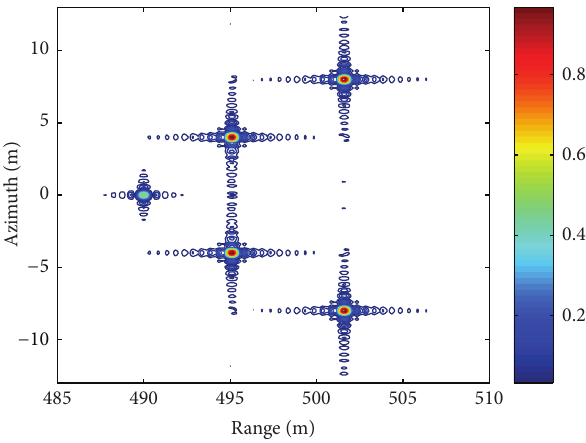
Figure 5: Azimuth and range 2D imaging results of the center an- tenna element.